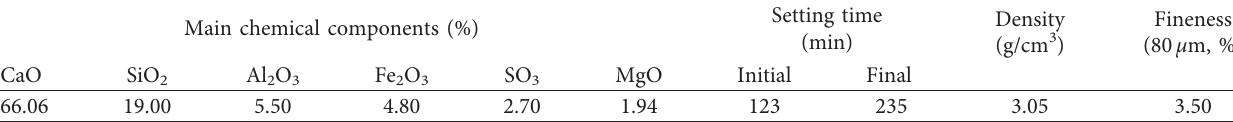
Table 2: Properties of ordinary Portland cement.